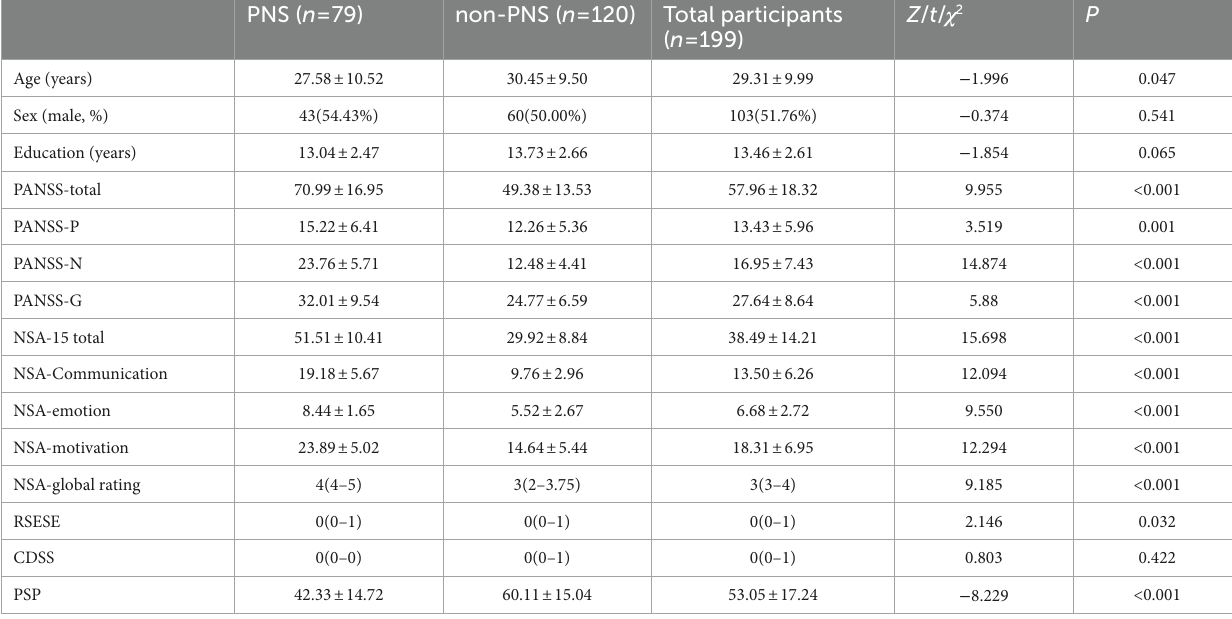
TABLE 1 Demographic and clinical information for patients with and without